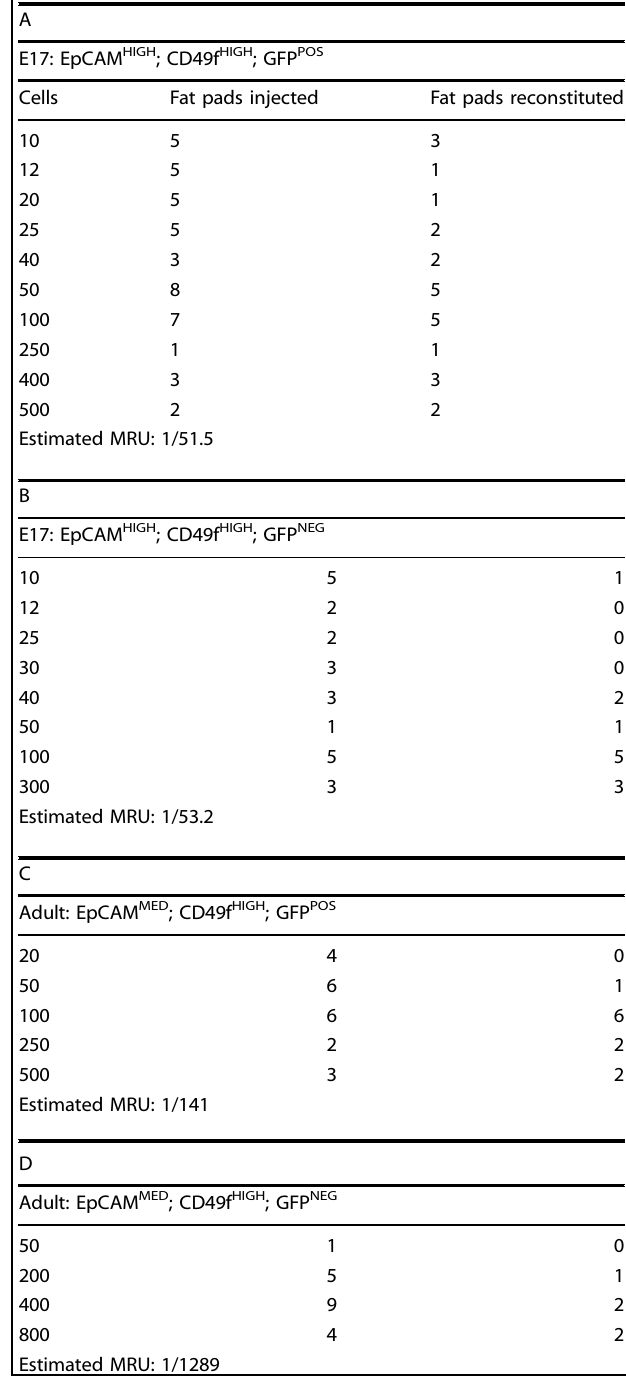
Table 1. LDTA on mammary epithelial cells sorted based on